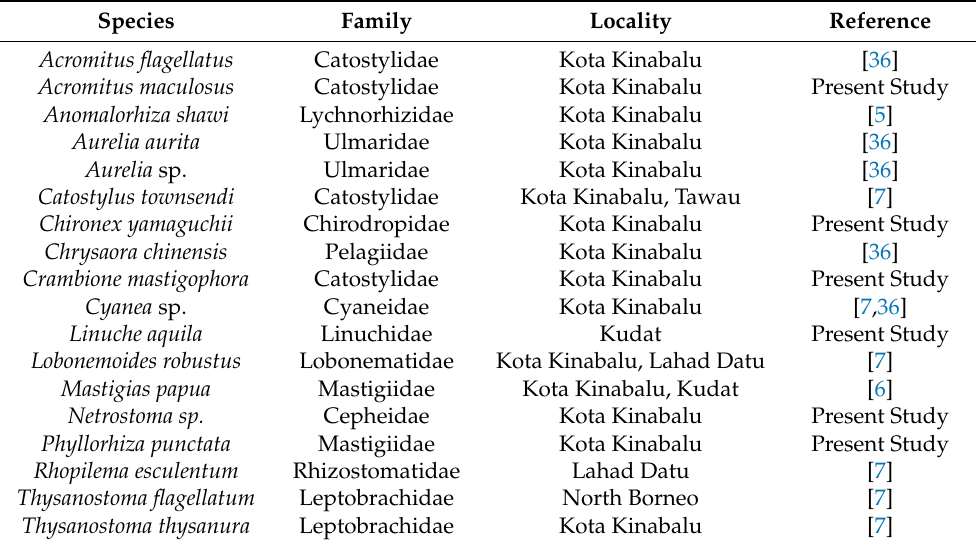
Table 2. A checklist of all hitherto recorded jellyfish species from Sabah waters,